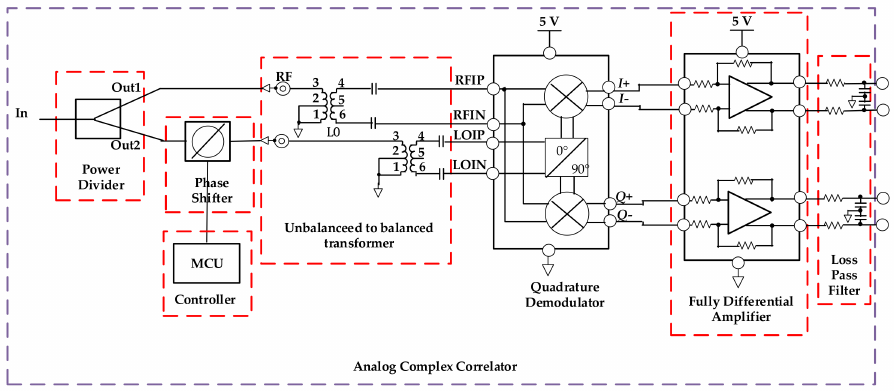
Figure 6. Design block diagram of complex correlator.